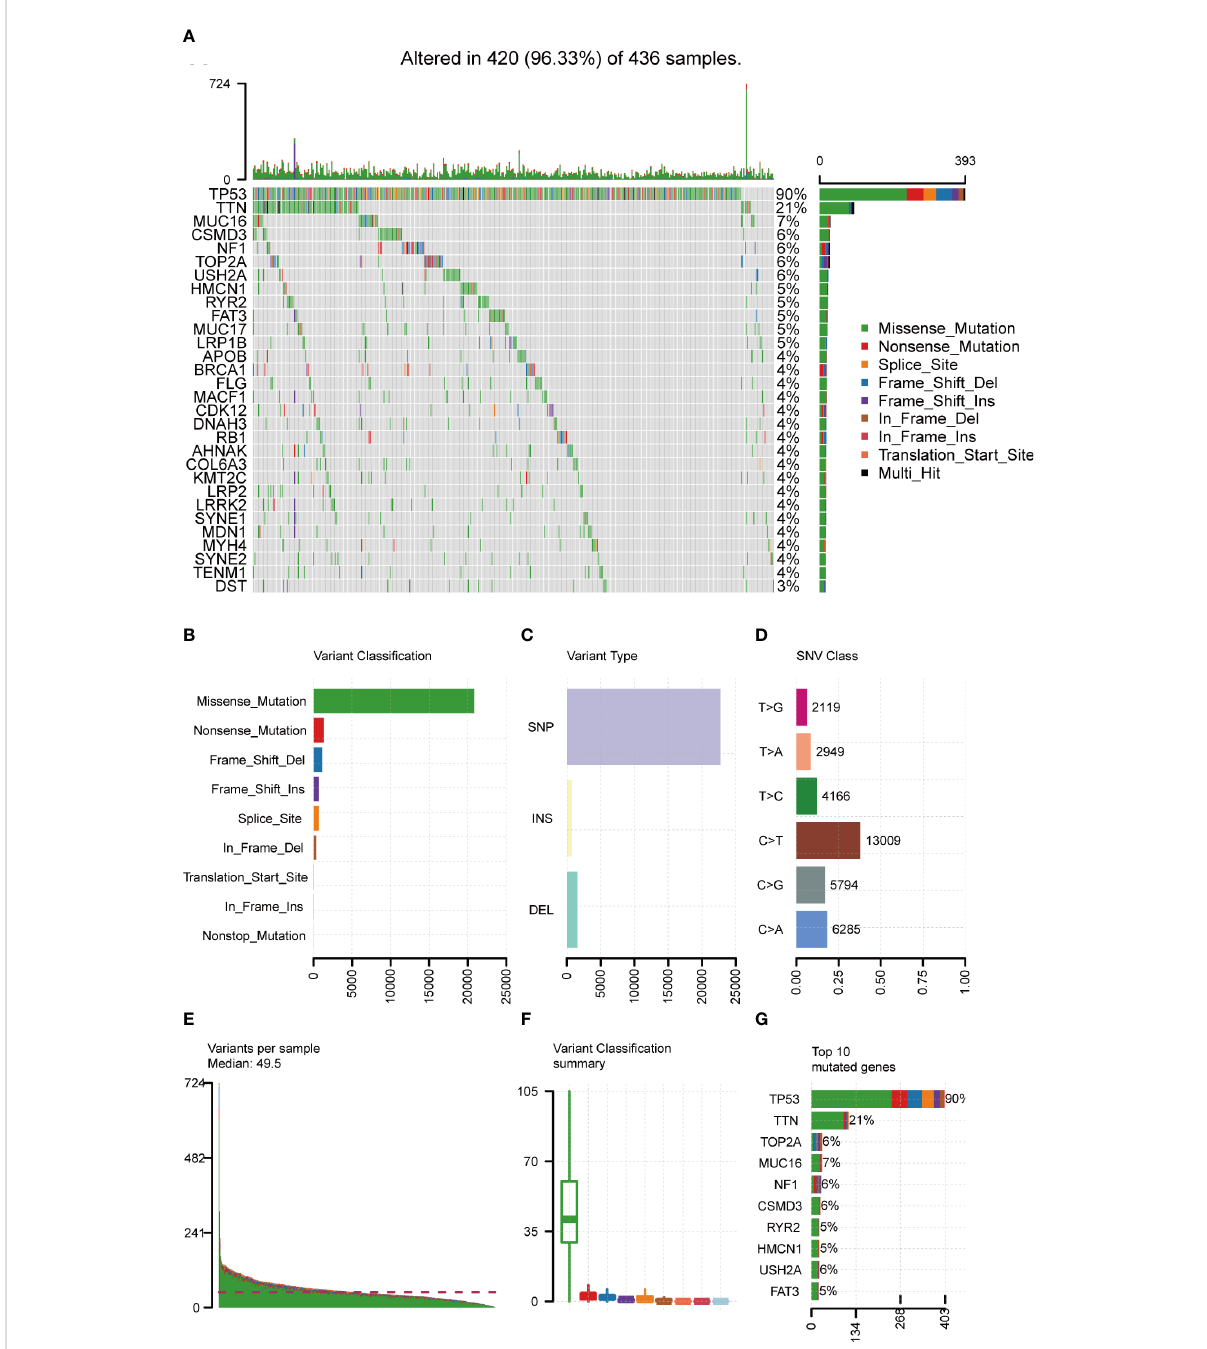
FIGURE 2 Landscape of mutation pro fi les in OC samples. (A) Mutation information of each gene in each sample was shown in the waterfall plot, with various color annotations to distinguish different mutation types. The barplot above the legend exhibited the mutation burden, and the other barplot on the right showed the distribution of mutation types among the top 30 genes. (B – D) According to different classi fi cation categories, missense mutation, SNP, and C > T mutation accounted for a larger proportion. (E) Mutation burden in each sample. (F) The summary of the occurrence of each variant classi fi cation. (G) Top 10 mutated genes in ovarian cancer. SNP, single-nucleotide polymorphism; SNV, single- nucleotide